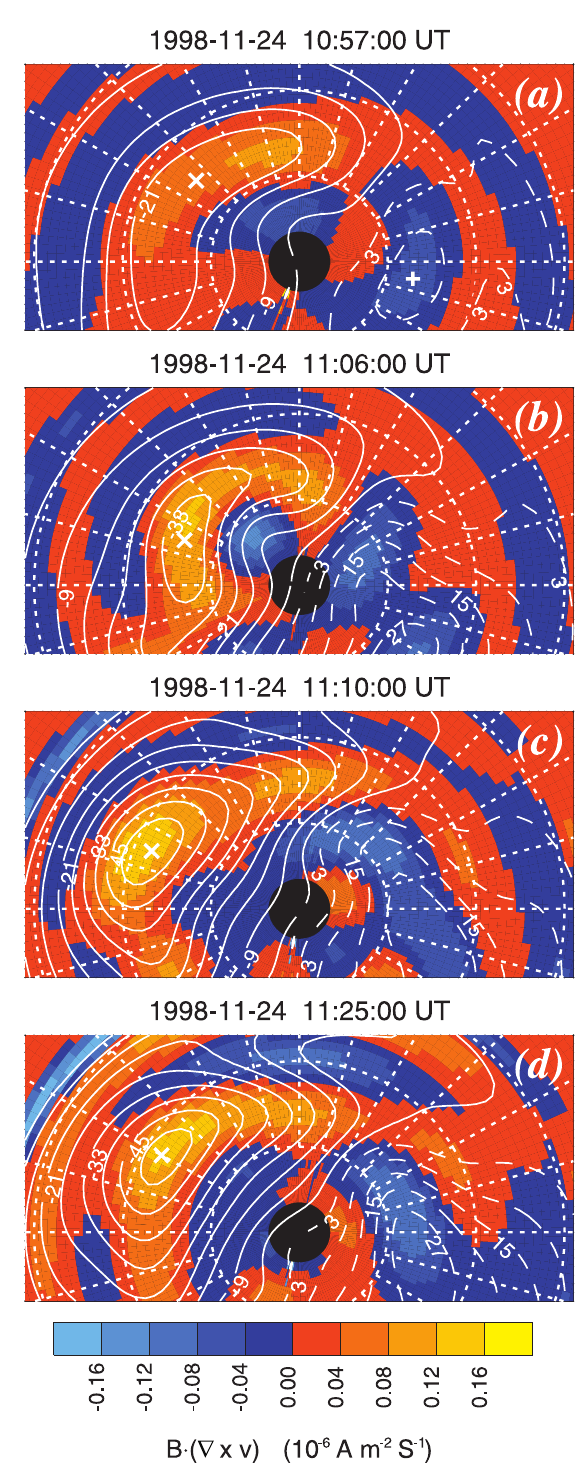
Fig. 10. The FAC estimate per unit Pedersen conductance B · ( ∇ × v ) ( µ A m − 2 S − 1 ) obtained from the map potential con- tours for the scans starting at (a) 10:57 UT, (b) 11:06 UT, (c) 11:10 UT, and (d) 11:25 UT. The FAC direction is defined according to the SuperDARN coordinate convention, where z is radially out of the ionosphere. Negative vorticity (into the ionosphere) corresponds to a positive FAC component (red), and positive vorticity (out of the ionosphere) corresponds to a negative FAC component